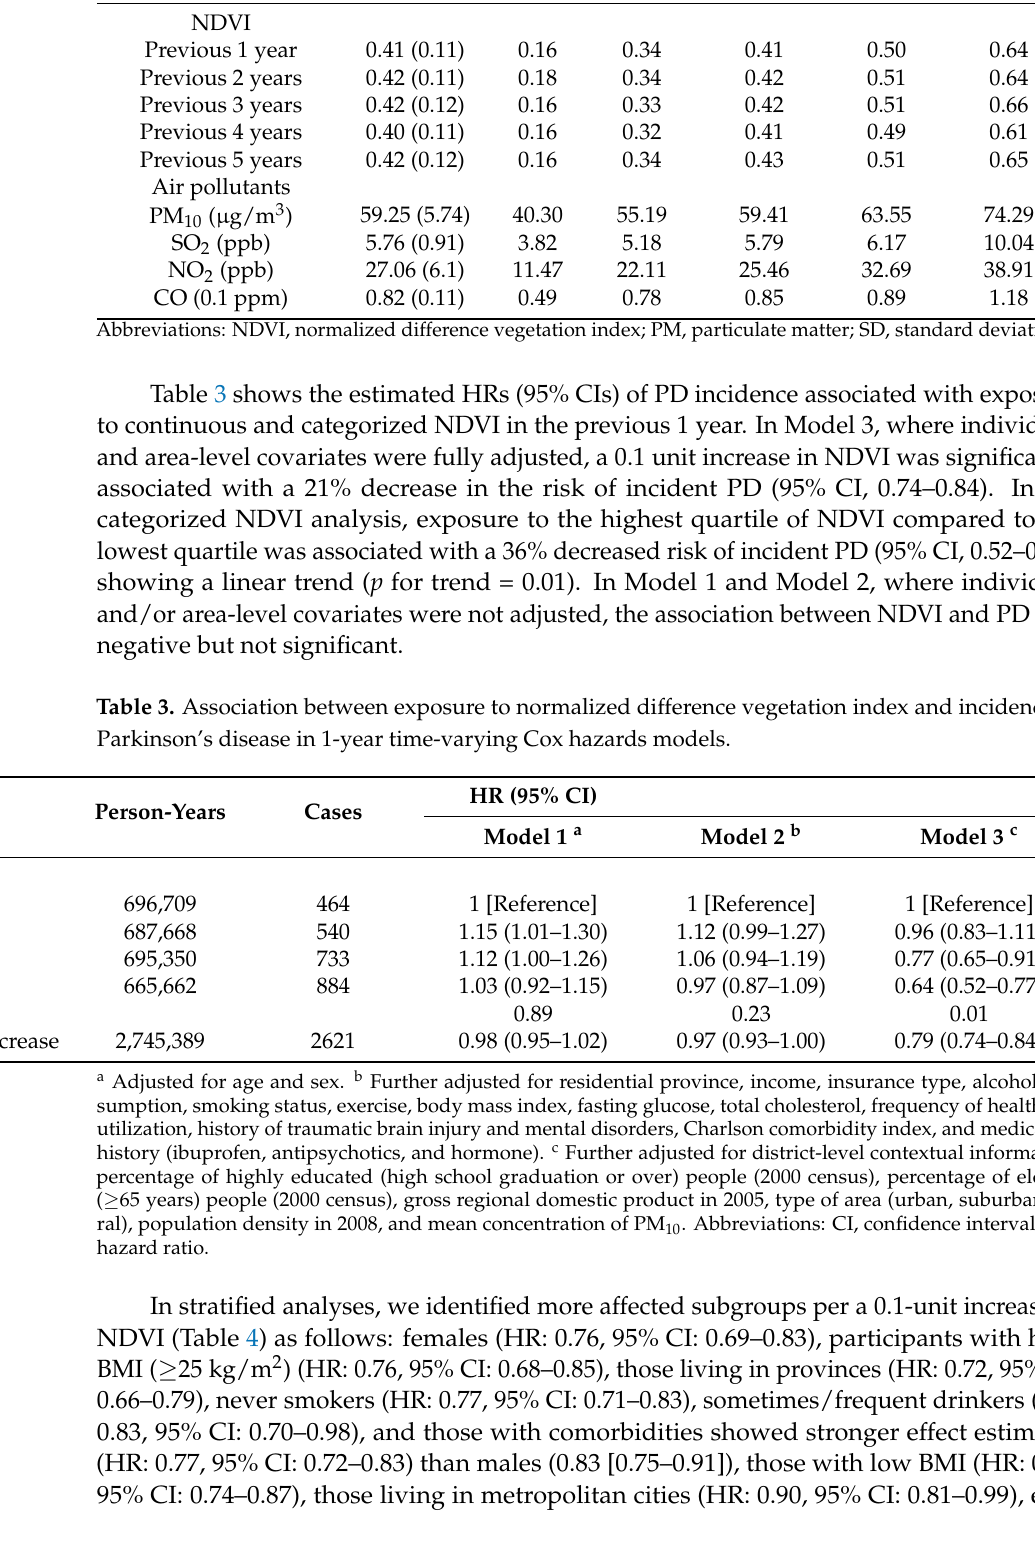
Table 2. Summary statistics of normalized difference vegetation index and air pollution concentra- tions for previous years of the first study year, 2007. Mean (SD)